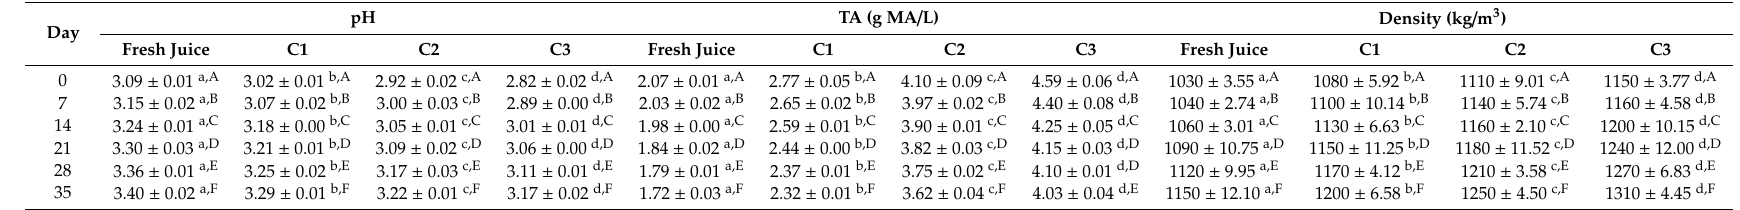
Table 2. Physicochemical parameters of fresh calafate juice and cryoconcentrate samples during